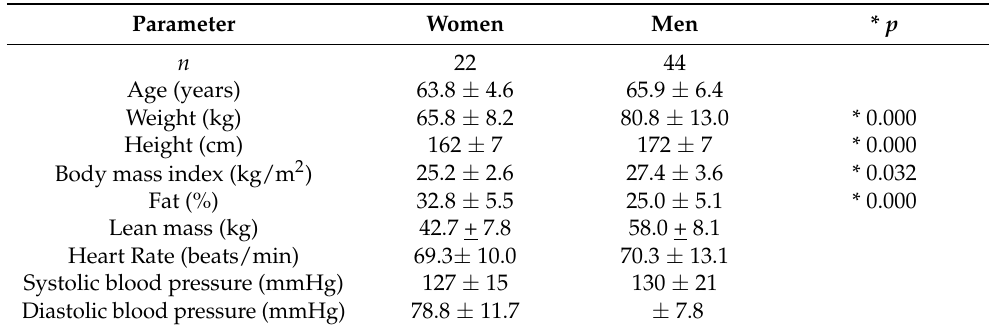
Table 1. Anthropometric parameters and blood pressure values of the women and men at the beginning of the study.